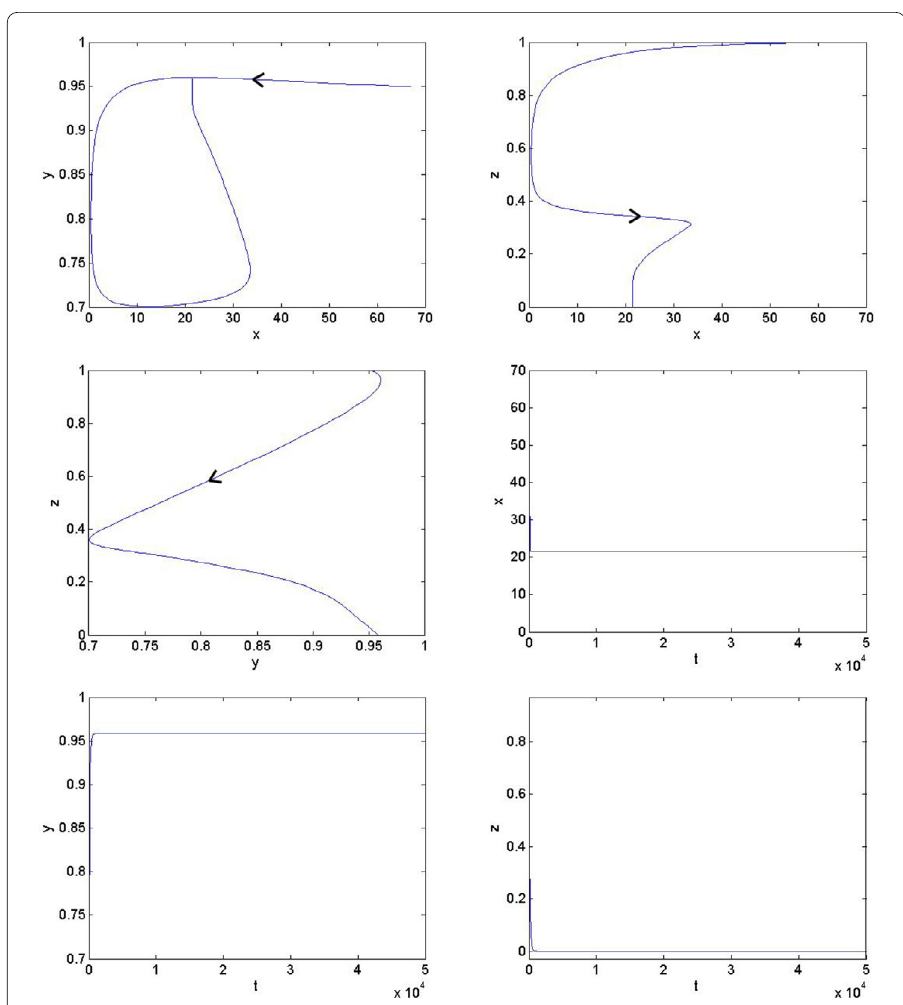
Figure 7 A computer simulation of the system of Eqs. (4)–(6) with c 1 = 0.9 day –1 , c 2 = 0.95 day –1 , c 3 = 0.239 day –1 , c 4 = 0.5 day –1 , c 5 = 0.10 day –1 , k 1 = 67.0, k 2 = 0.81, k 3 = 0.9, h 1 = 0.024, h 2 = 0.063, e 1 = 0.0001 day –1 , e 2 = 0.42 day –1 , e 3 = 0.4 day –1 , γ 1 = 0.01 day –1 , γ 2 = 0.03 day –1 , (cid:8) = 0.05 and δ = 0.9